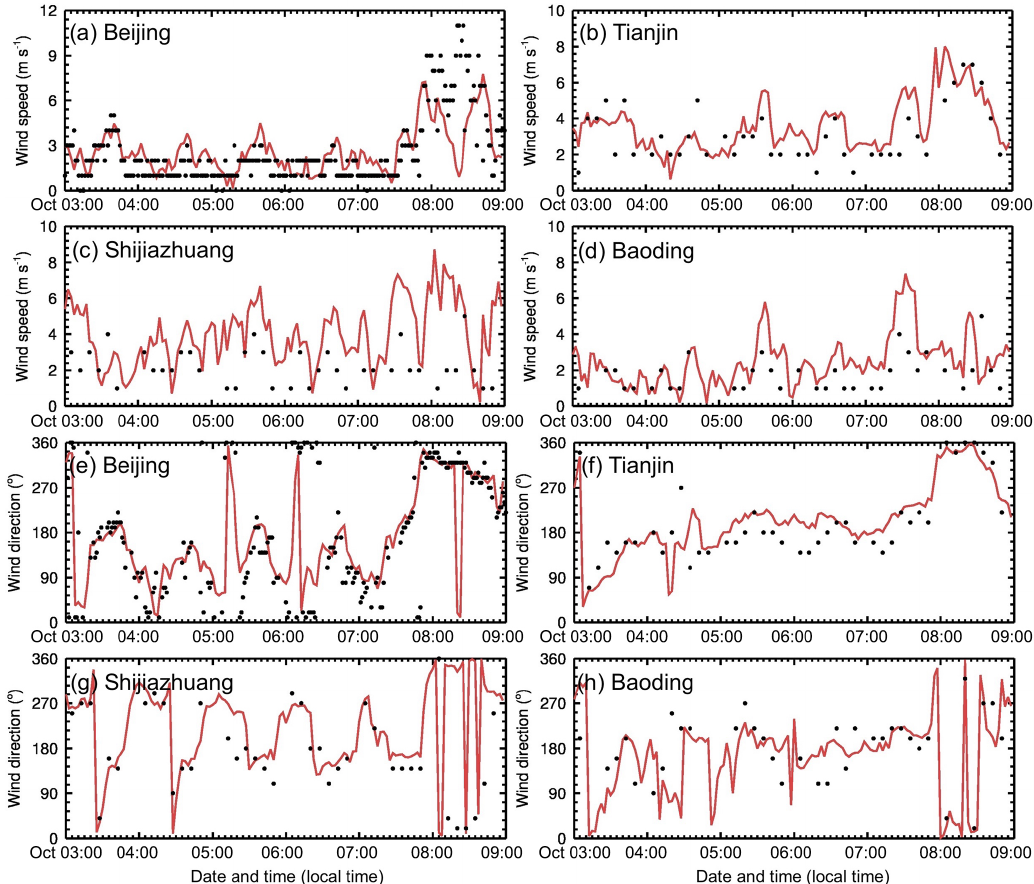
Figure 5. Simulated (red curves) and observed (black dots) temporal profiles of surface (a–d) wind speed and (e–h) wind direction in (a, e) Beijing, (b, f) Tianjin, (c, g) Shijiazhuang, and (d, h) Baoding from 3 to 8 October